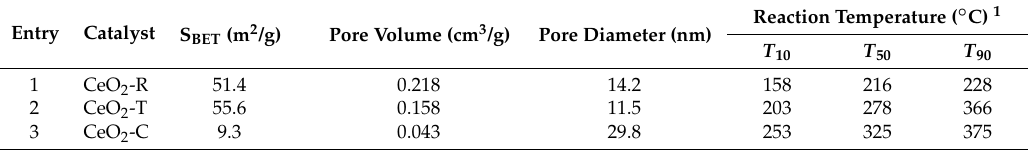
Figure 3. N 2 adsorption-desorption isotherms ( a ) and pore size distribution ( b ) of CeO 2 with different morphologies. Table 1. Textural properties of CeO 2 samples and their catalytic performance for CO oxidation.